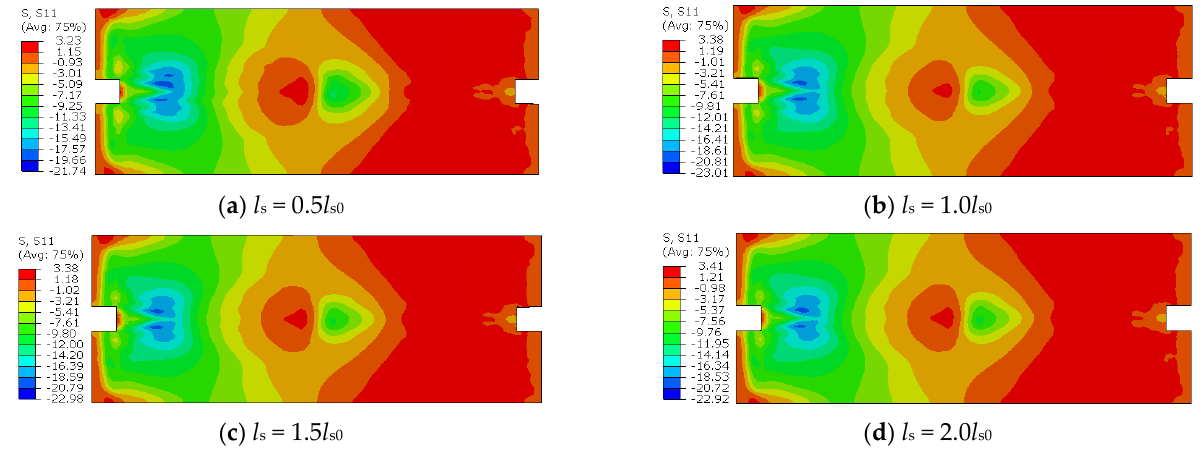
Figure 17. Stress nephograms of a concrete slab for different l s values.